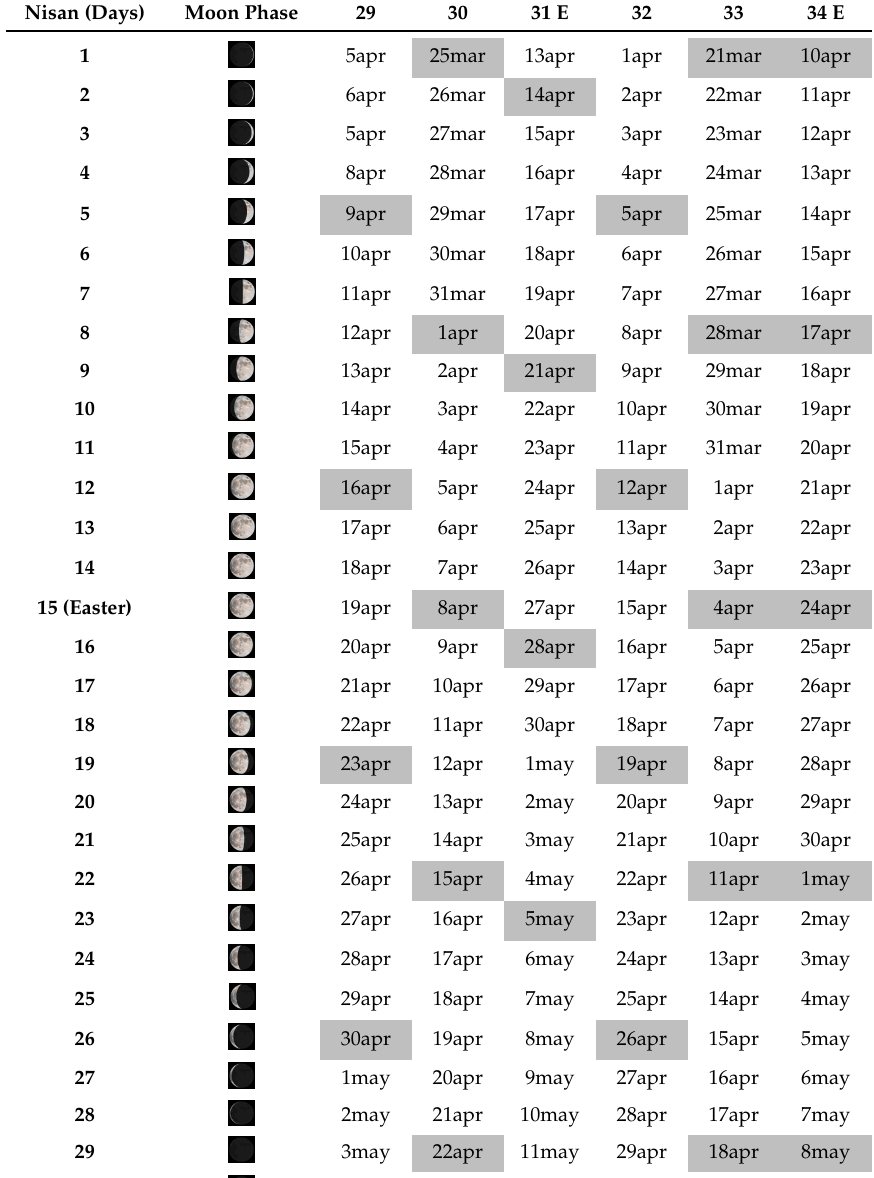
Table 1. Reconstruction of the days of Nisan for the years 29–34. Saturdays are indicated by gray boxes. The “E” indicates the embolismic years of 13 months.